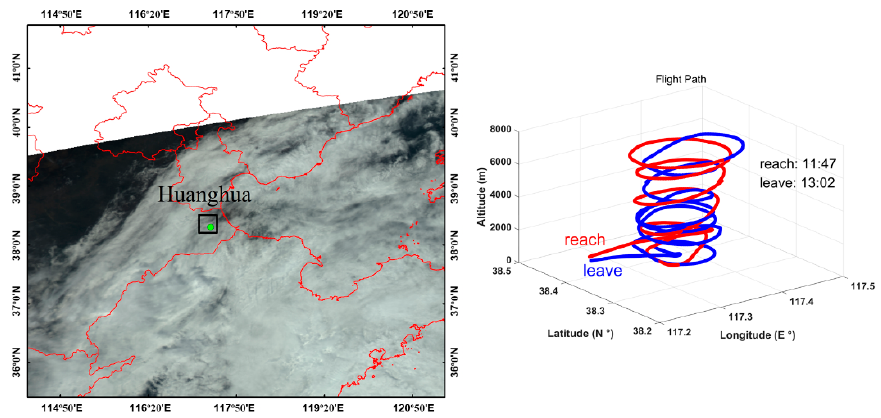
Figure 1. Flight tracks ( right ) over the observation location at Huanghua, China on 26 April 2014, along with the satellite map of clouds ( left ) from the Moderate Resolution Imaging Spectroradiometer (MODIS) at 10:30 LT on the same day.